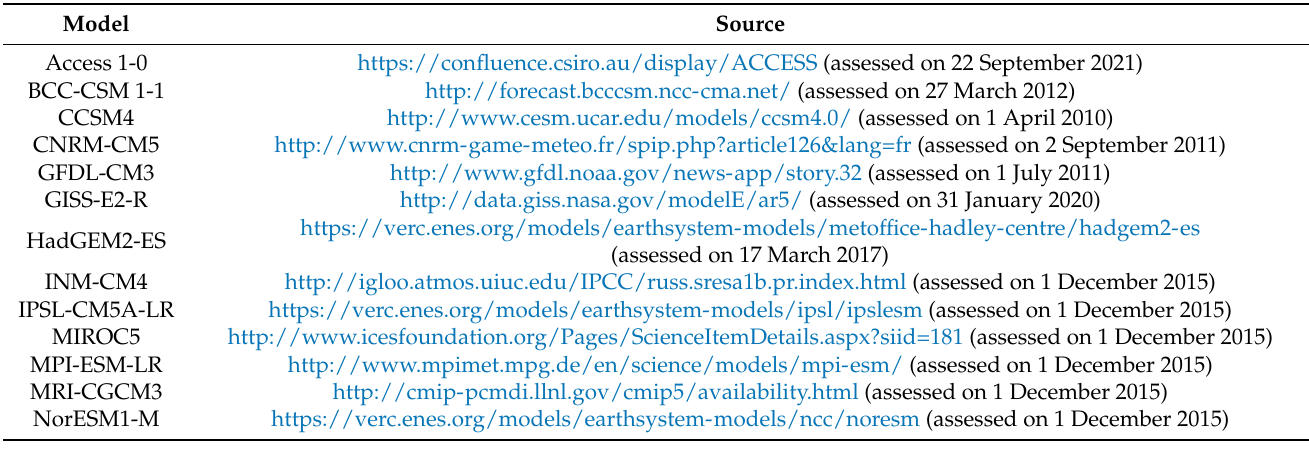
Table 1. List of global circulation models used to realize the consensus maps of bioclimatic variables for computing Emberger’s Index for the future